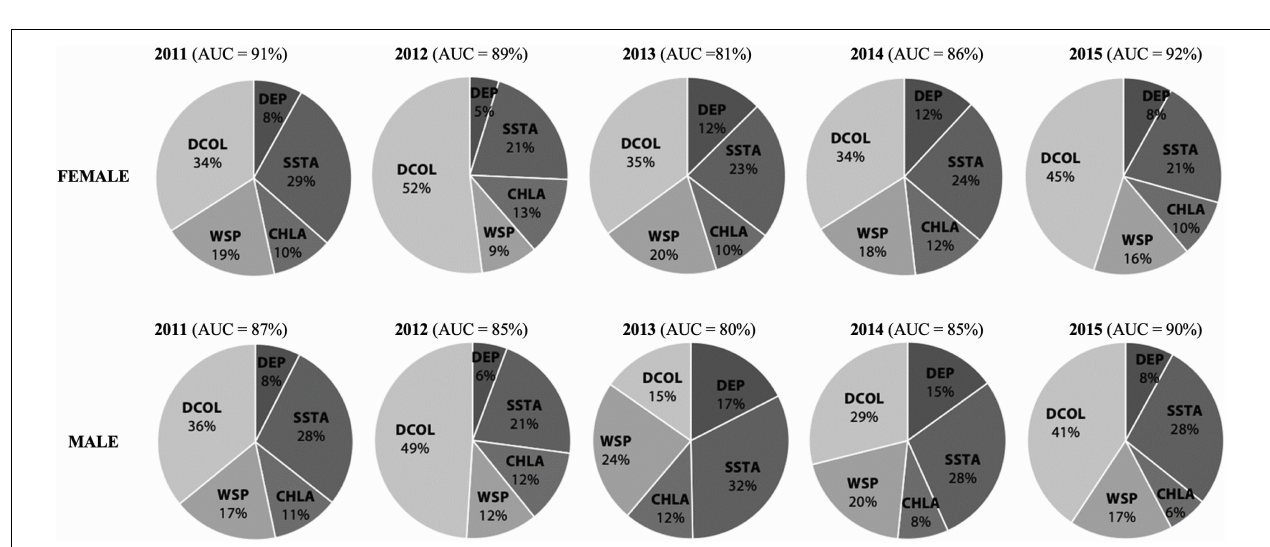
FIGURE 2 | Monthly 50% (filled polygons) and 95% (line) kernel utilization distributions (UDs) of female (red) and male (blue) sooty terns from Ascension Island carrying GLS tags between 2011 and 2015. The yellow circle represents the MPA that extends 200 nautical miles around Ascension Island. Ocean depth is represented in the background.